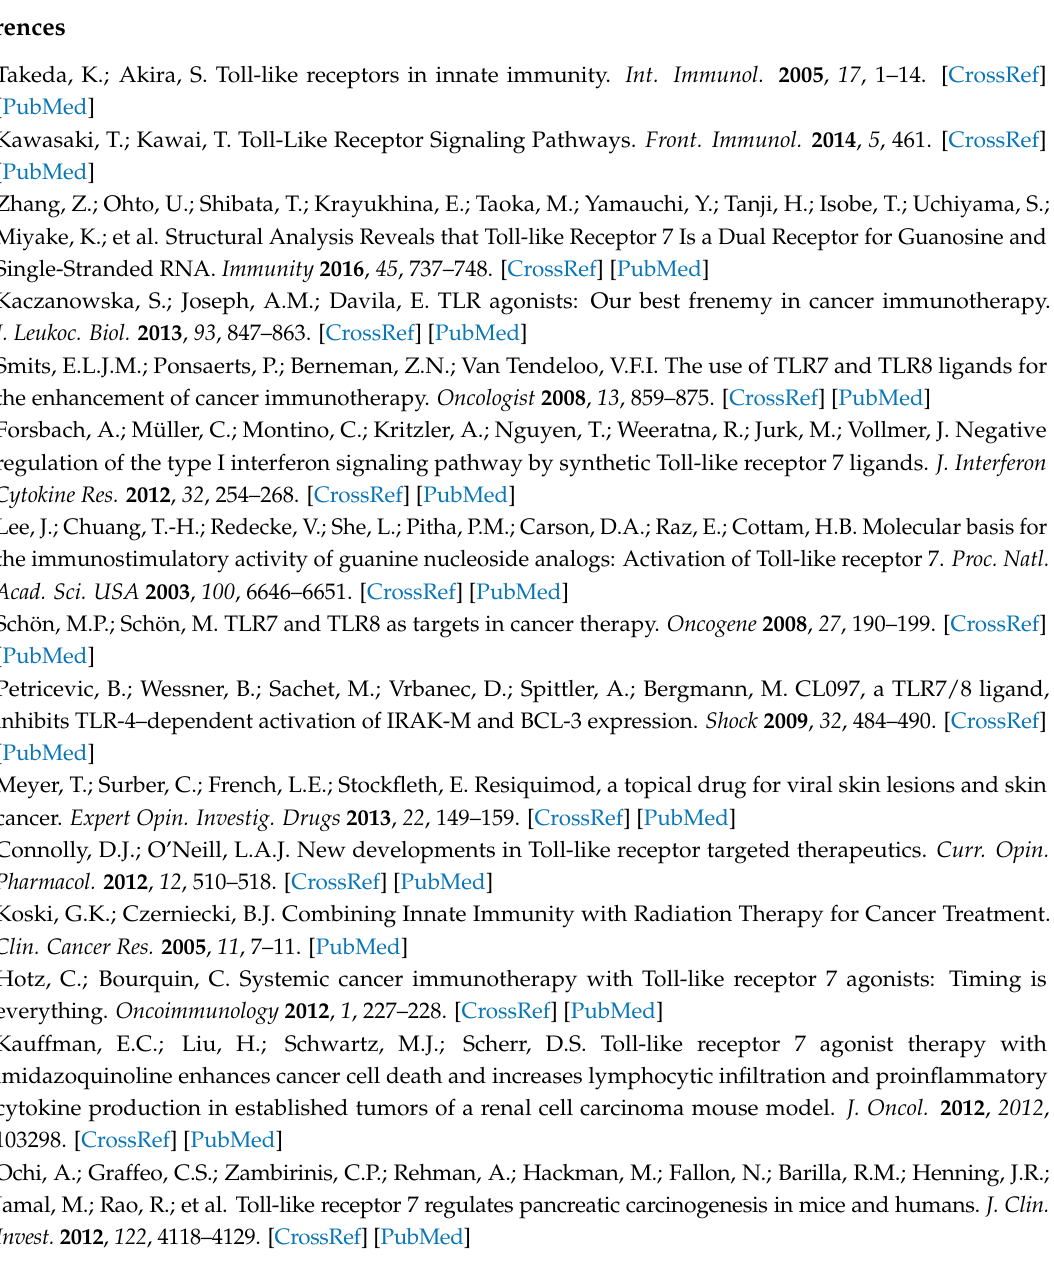
Supplementary Materials: Figure S1: The additional four poses of CR42-24 obtained with molecular docking to the R-837 binding site of TLR7. Figure S2: Superposition of the crystallographic pose of DAMA-colchicine in tubulin from pdb ID 1SA0 and the CR42-24 docking pose in TLR7. Figure S3: RMSD trends for the MD production simulation, calculated using the average structure of the last 5 ns as reference. Figure S4: Salt bridge established between aD555 and bK432, keeping the former far from the amine of CR42-24. Table S1: List of the cell lines in the Oncolines™ panel and their genetic